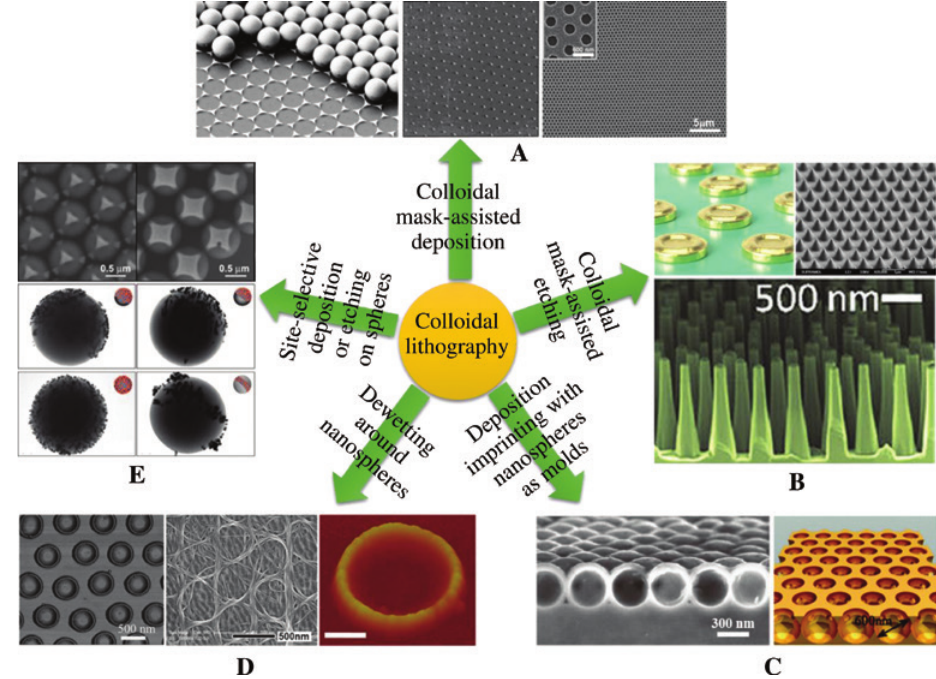
Figure 1: CL methods to fabricate nanostructures. (A) Colloidal mask-assisted deposition to fabricate triangular nanoparticles [8] (left), nanodots [9] (middle), and nanohole arrays [10] (right). (B) Colloidal mask-assisted etching to fabricate nanodisks (top left) [11], nanotips [12] (top right), and nanopillars [13] (bottom). (C) Deposition or imprinting with nanospheres as molds to fabricate spherical nanoshells [14] (left) and nanovoids [15] (right). (D) Dewetting around nanospheres to fabricate nanorings of PS polymers (left) [16], carbon nanotubes (CNTs) [17] (middle), and CdSe nanoparticles [18] (right). (E) Site-selective deposition or etching to fabricate patchy spheres [19] (upper panel) and silica particle labeled with Au NPs [20] (bottom